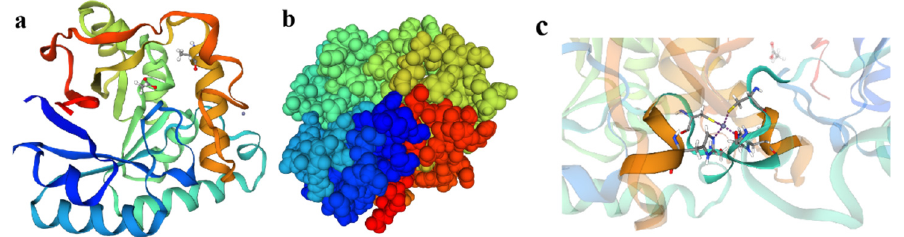
Figure 6. ( a ) Cartoon representation of the collagenase obtained from the SWISS-MODEL (https://swissmodel.expasy.org/ accessed on 6 May 2022). The gray ball represents zinc ion. Prediction and interpretation the zinc ion and acetate ion were through QM/MM optimization. Both the polarization by the catalytic site Zn301 and the interaction with the acetate moiety of Glu227 promote the elongation of the O-H bond of the Zn-ligated nucleophilic water [33]. ( b ) Spacefill representation of the collagenase ( c ) SWISS-MODEL matched template (SMTL ID: 5d88.1 The Structure of the U32 Peptidase Mk0906), U32 collagenase family. The interaction between zinc ions and residues is shown. According to the results of the experiment, it is also proved that Ca 2+ and Zn 2+ bind, which promotes the occurrence of enzymatic lysis and the improvement of enzymatic activity [24,34,35].